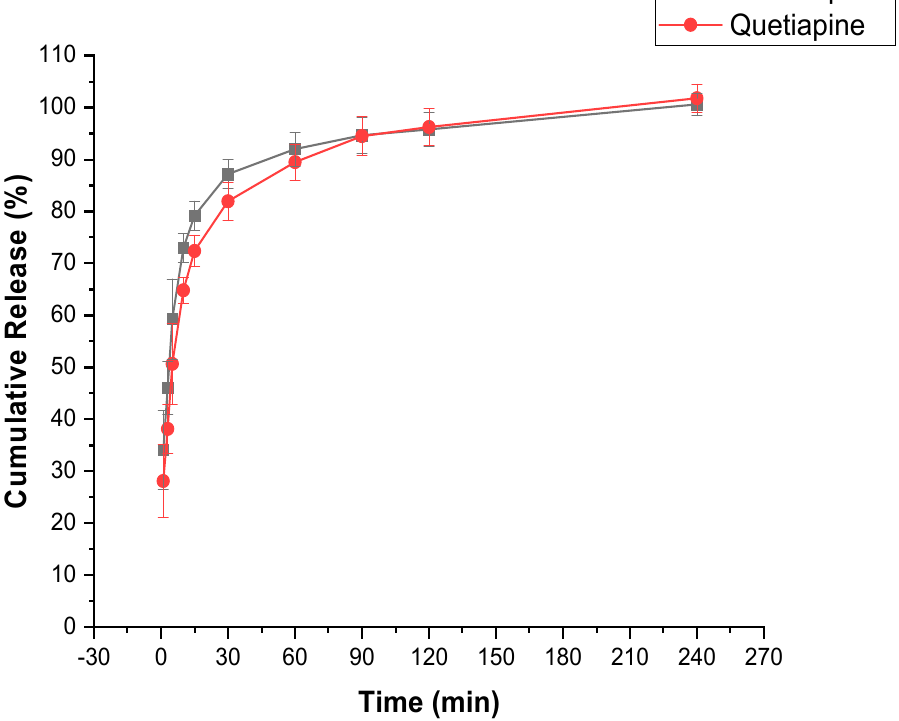
Figure 7. In vitro dissolution profile of the drug-loaded fibers, showing the release of more than 50% of ESC and QUE in the first 5 min and a full release of both drugs after 120 min.